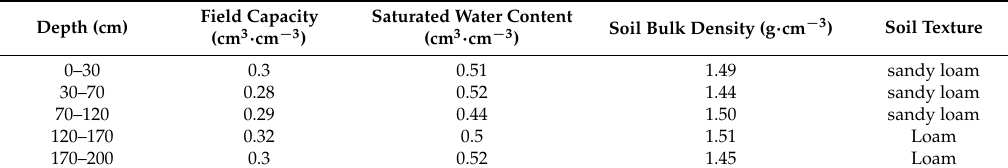
Table 1. Physical Parameters of Experimental Soil.